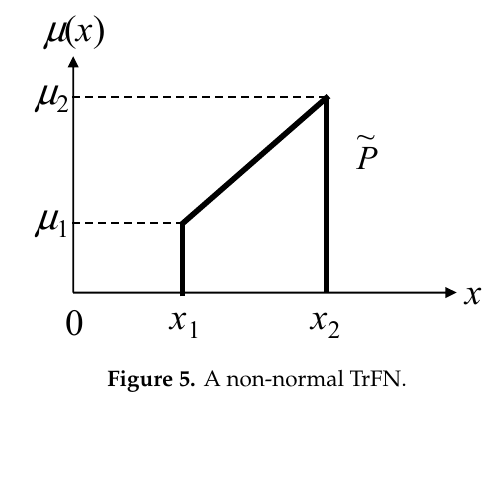
Figure 5. A non-normal TrFN.